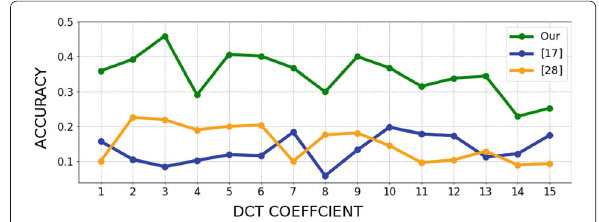
Fig. 6 Average accuracy of the estimation for each DCT coefficient (first is DC) employing custom tables with QF 2 =